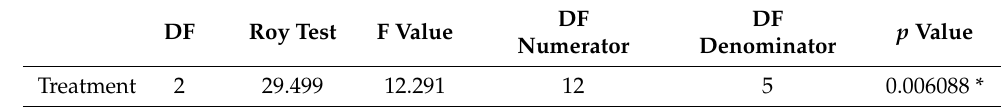
Table 8. MANOVA results in Exp. 2. DF